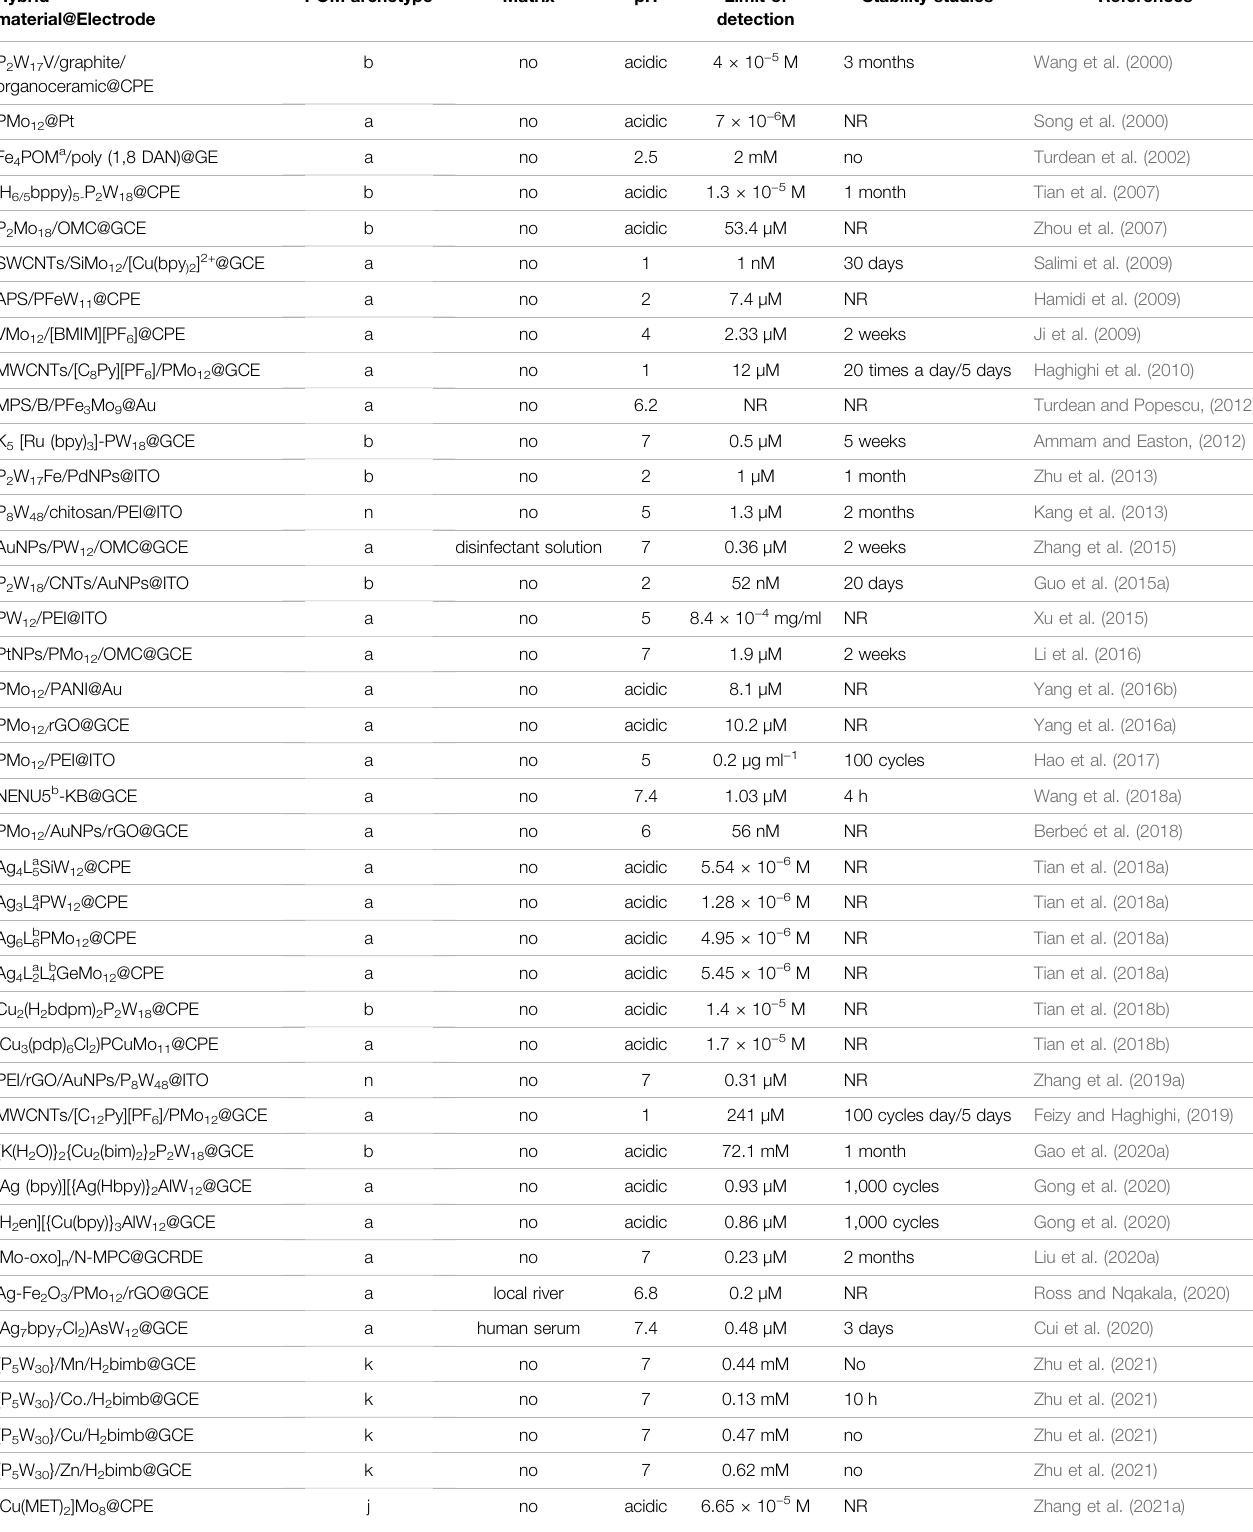
TABLE 1 | POM-based electrochemical sensors for H 2 O 2 detection. Hybrid